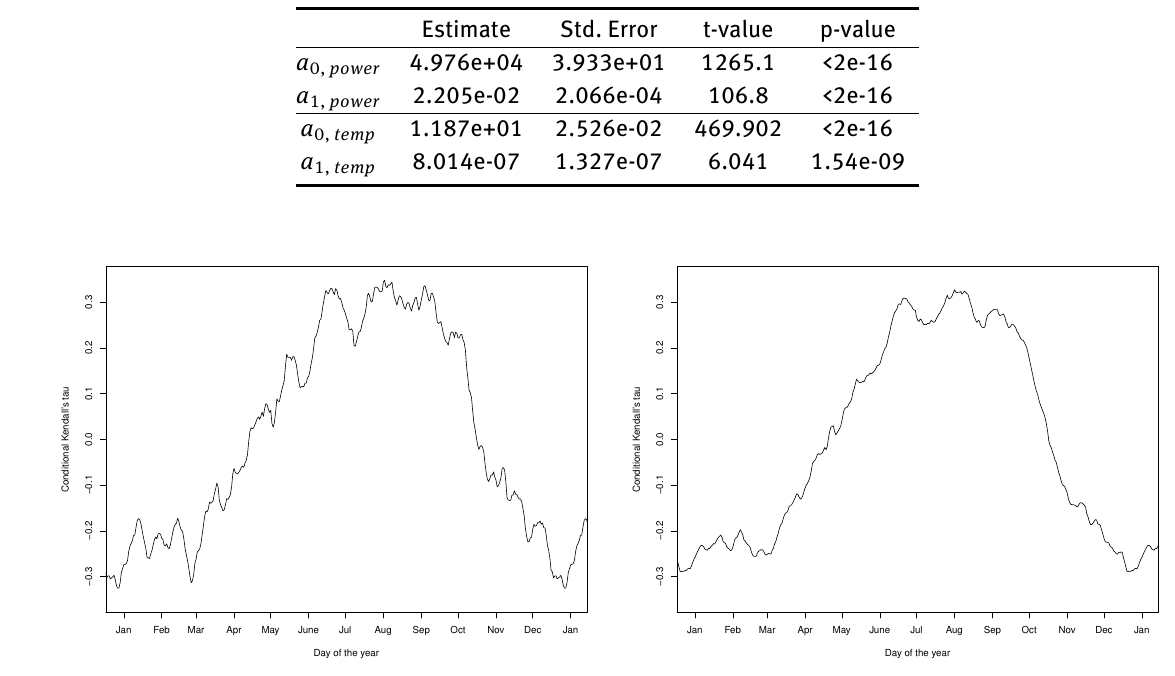
Figure 5: Conditional Kendall’s tau between the detrended electricity consumption ˆ ε 1, t and the detrended temperature ˆ ε 2, t , given the day of the year and estimated using h CV days.